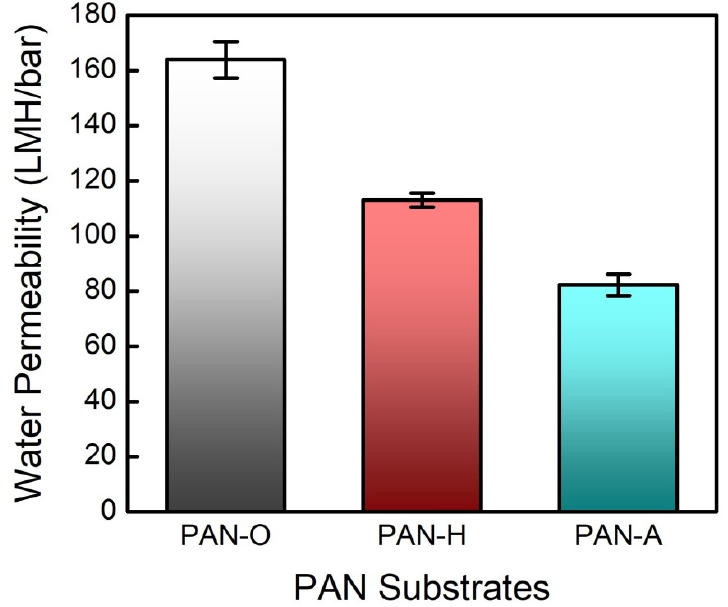
Figure 3. Evaluating the original PAN substrate and the PAN substrates with the heat treatment and alkaline treatment in terms of their water permeabilities. The flux–pressure relationship was determined with a hydraulic pressure of 5 bar; the error bars correspond to the standard deviations of three independent measurements.